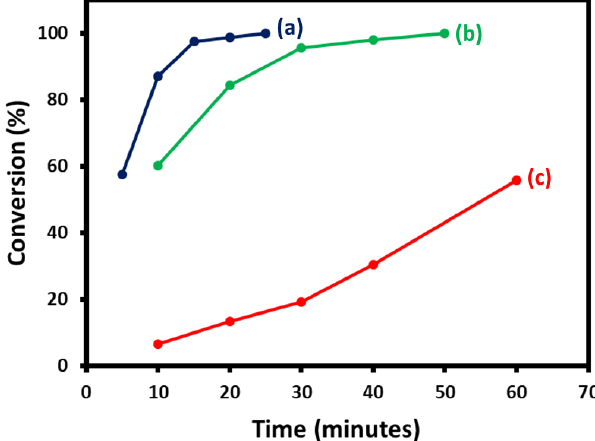
Figure 12. Time-dependent conversion efficiency of the Suzuki reaction employing NDG@Pd for various substrates (( a ) iodobenzene, ( b ) bromobenzene, and ( c ) chlorobenzene) with phenylboronic acid under aqueous and aerobic conditions (determined by gas chromatography (GC) analysis).